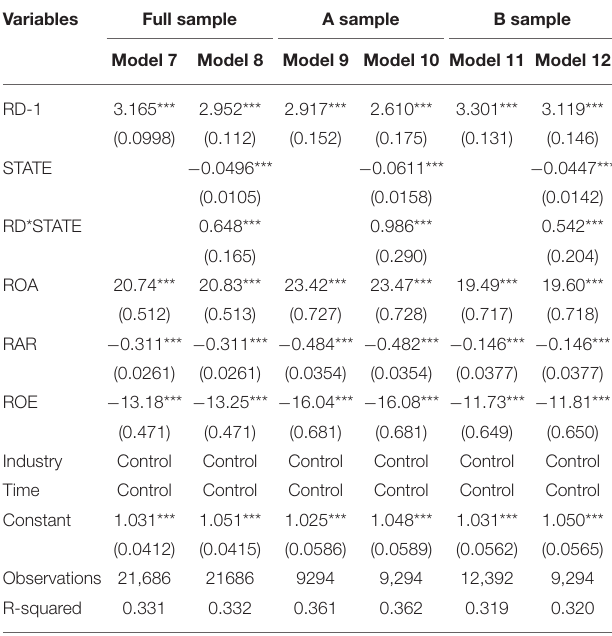
TABLE 1 | Relationship between Z -value and financial risk.